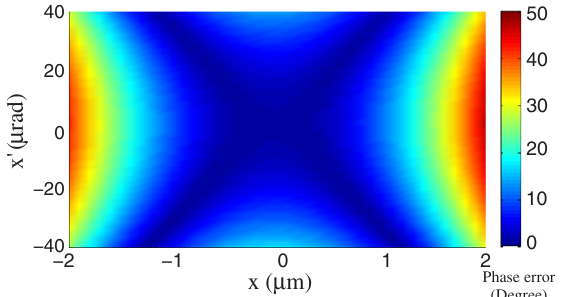
FIG. 3. Radiation phase errors for electrons with different initial x − x 0 conditions.